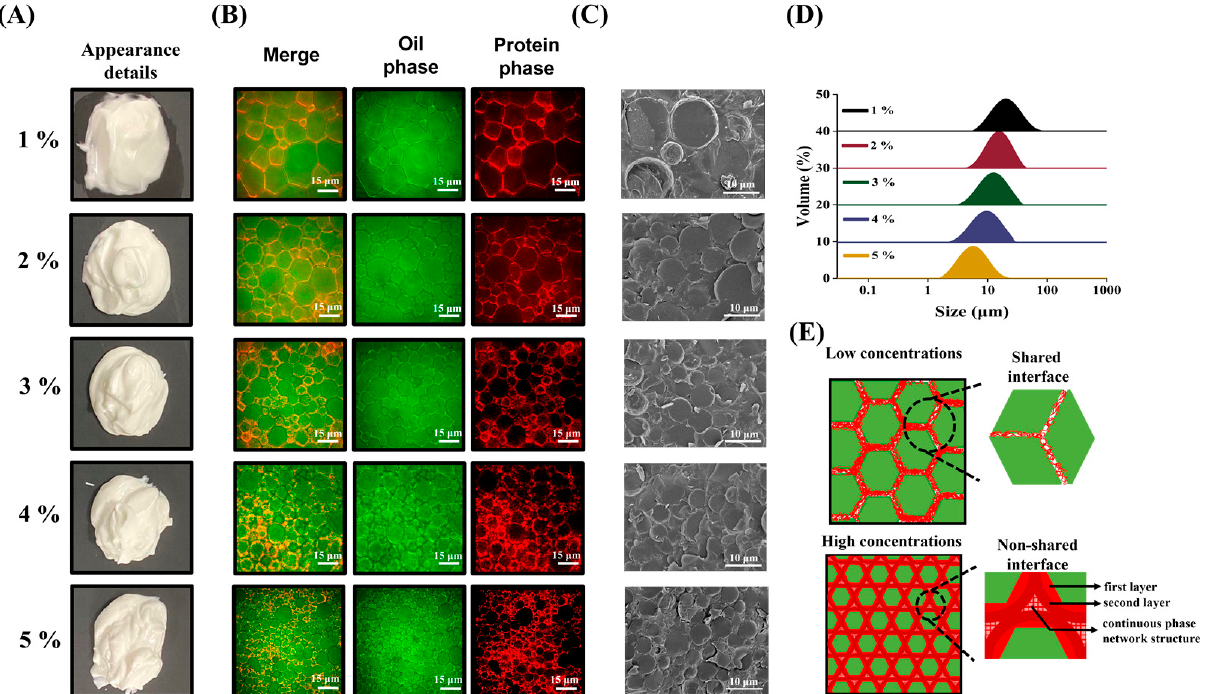
Figure 2. ( A ) Appearance details, ( B ) super-resolution microscopy, ( C ) cryogenic scanning electron microscopy, ( D ) droplet size and ( E ) schematic diagram of emulsi fi cation process and stabilization mechanism HIPEs stabilized by 1–5 wt% MPPI.